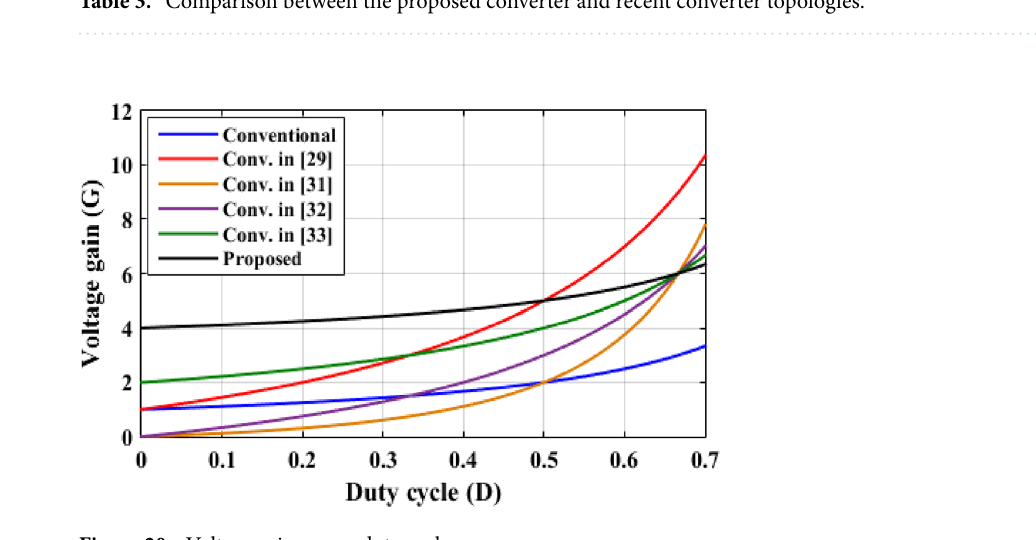
Figure 20. Voltage gain versus duty cycle.